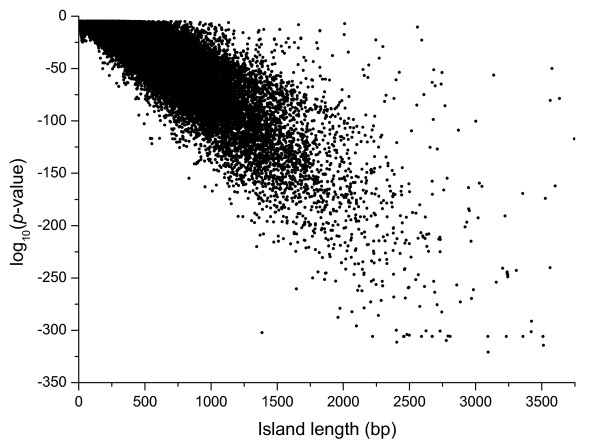
The length of CpGcluster islands vs. the logarithm of the assigned p-value. It can be seen that no linear correlation exists and that the relation between p-value and length is more complex, e.g. the p-value depends on both the island length and the island density.